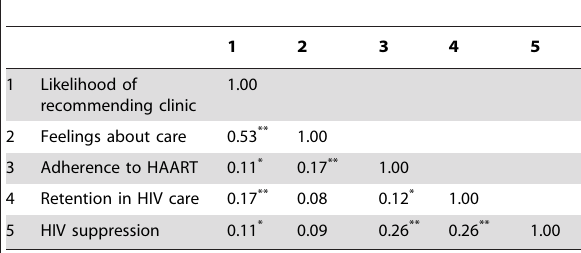
Table 1. Baseline characteristics of participants (N= 489). Table 2. Correlation Matrix.